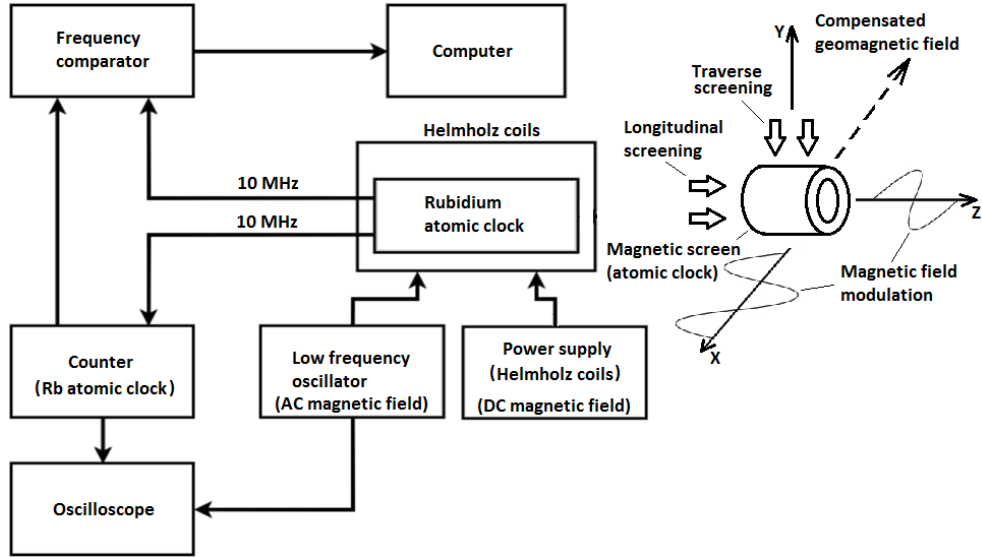
Figure 3. Laboratory setup used to study the orientational frequency shift of the rubidium atomic clock.